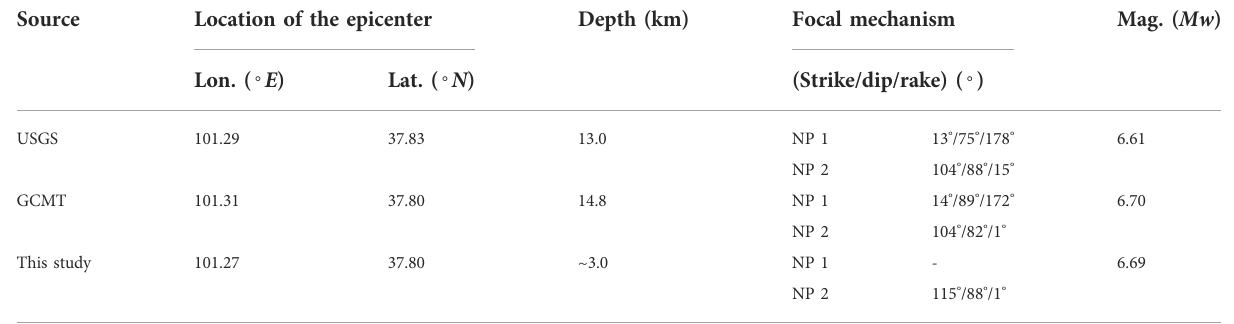
TABLE 1 Focal mechanisms of the 2022 Menyuan earthquake reported by different